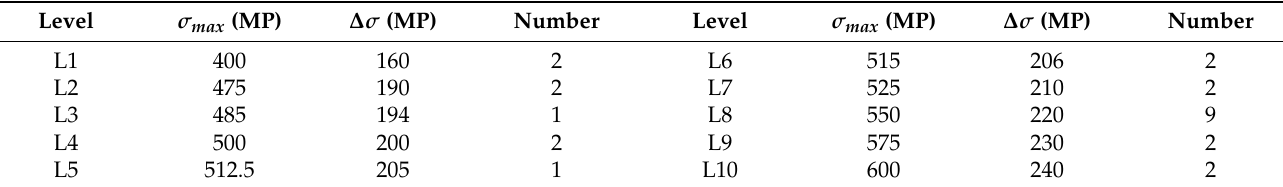
Table 3. Details of testing program.